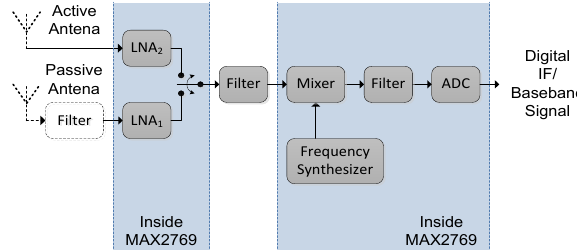
Figure 3. Developed RF front-end prototype block diagram.